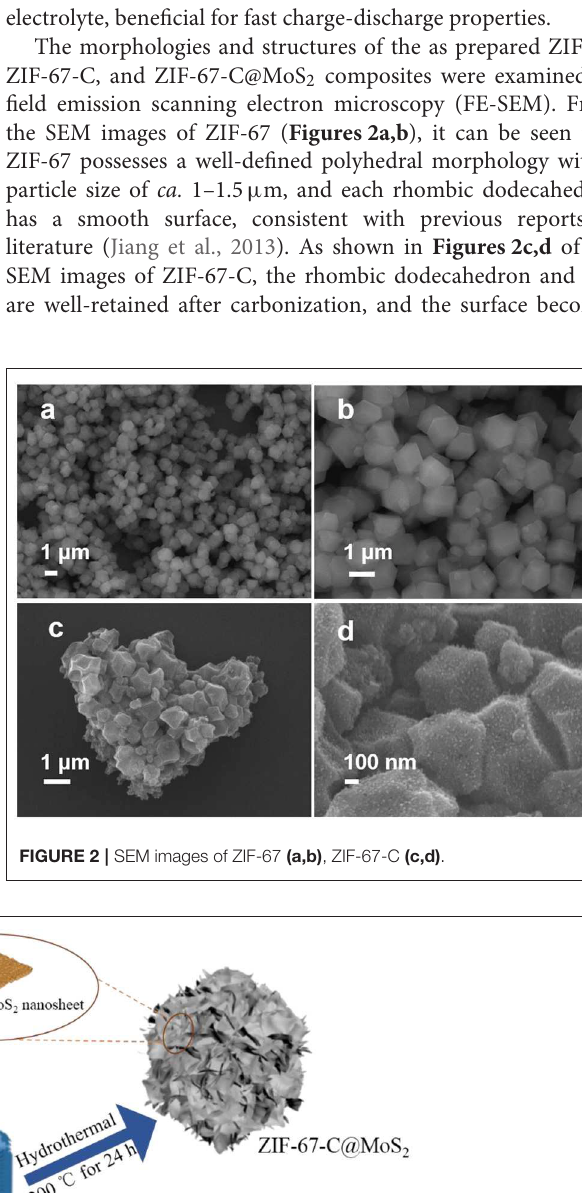
Frontiers in Energy Research |